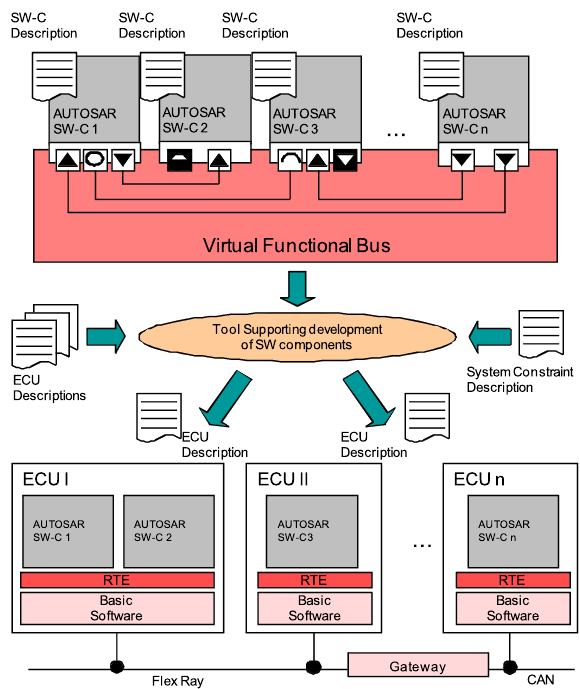
Figure 3. Mapping of software components to